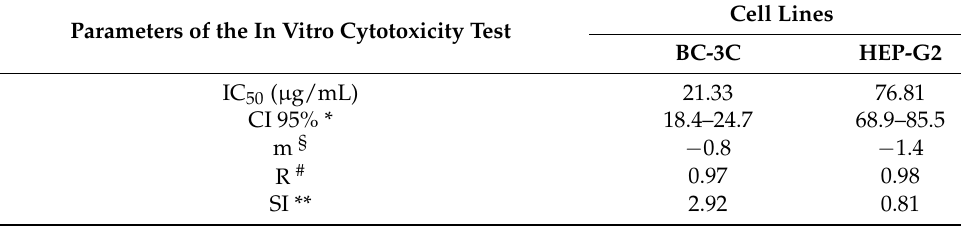
Table 3. In vitro cytotoxicity of EtOAc-AP extract of G. urbanum on the tumor cell lines BC-3C and HEP-G2 after 72 h of incubation.